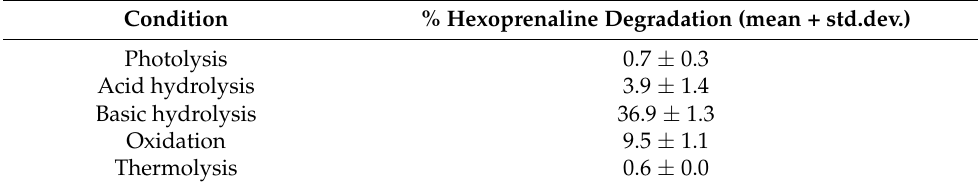
Table 4. Results of forced degradation studies on hexoprenaline.